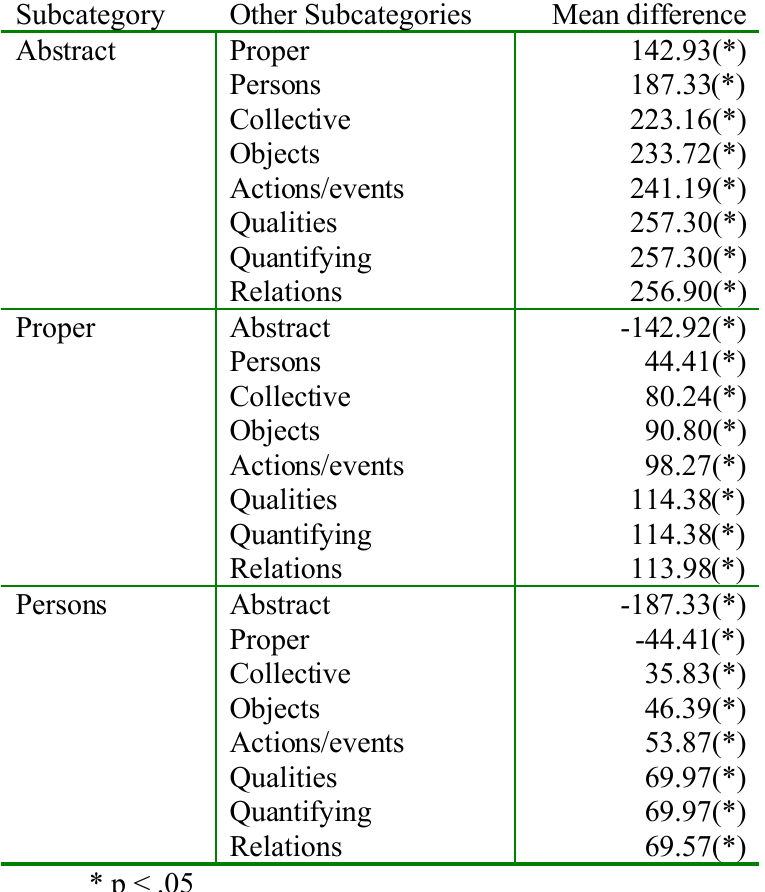
Scheffé Post Hoc Comparisons of Noun